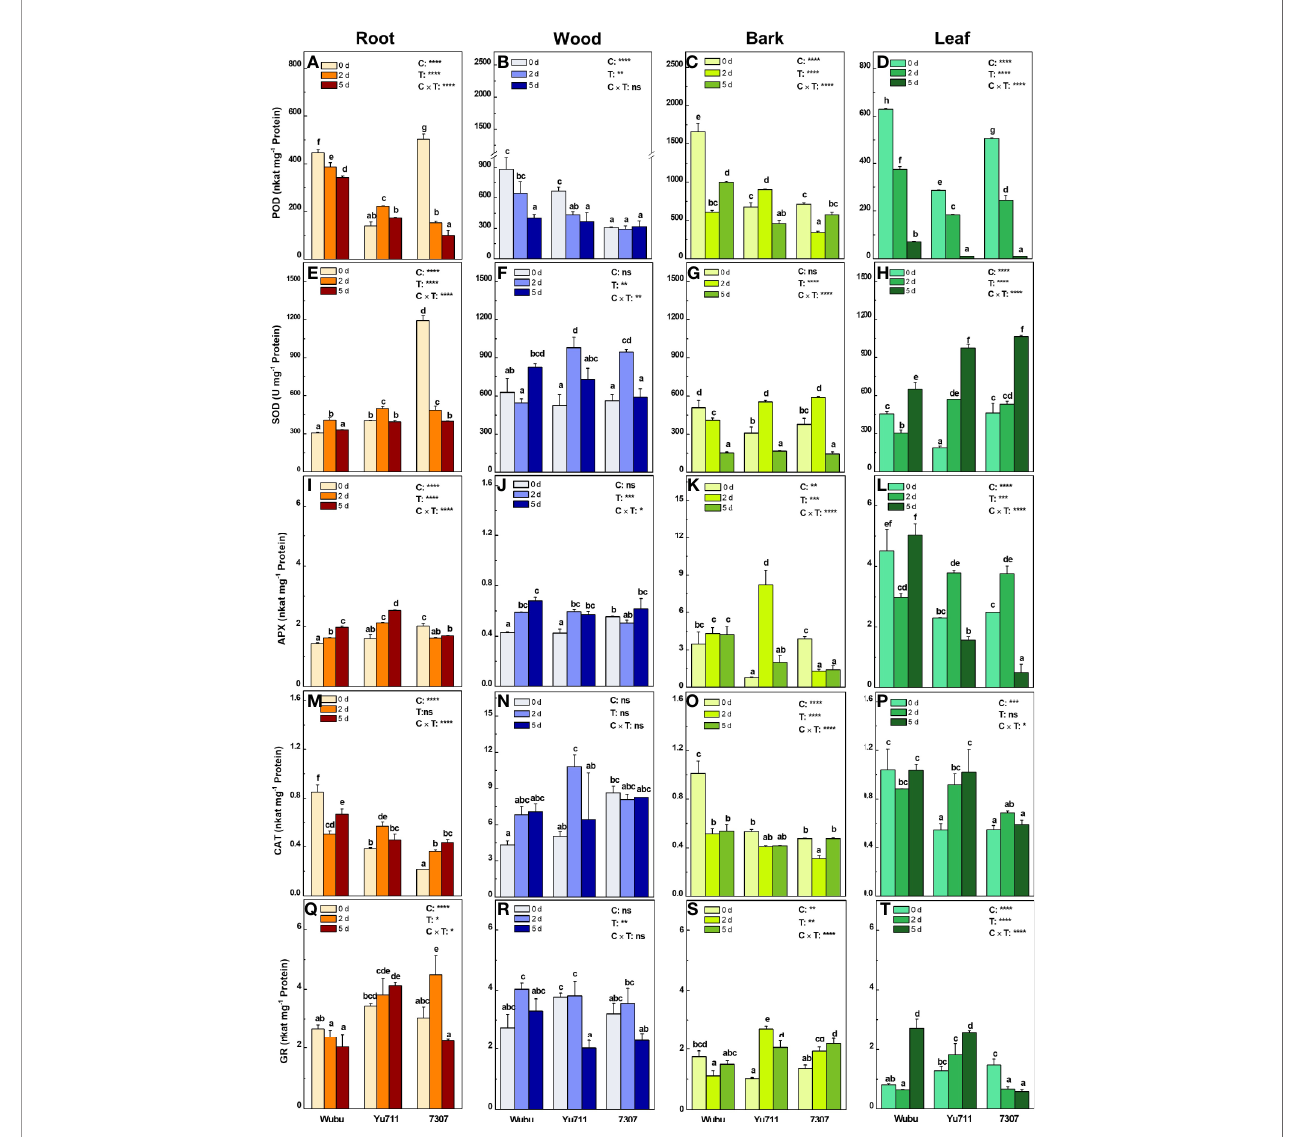
FIGURE 7 | Activities of POD (A – D) , SOD (E – H) , APX (I – L) , CAT (M – P) and GR (Q – T) in roots, wood, bark, and leaves of mulberry cultivar Wubu, Yu711, and 7307 exposed to progressive drought stress for 0, 2, and 5 days (denoted as 0 d, 2 d, and 5 d), respectively. The bar indicates mean ± SE (n = 6). Different letters on the bars indicate signi fi cant difference. ANOVAS of cultivars (C), time (T) and their interaction (C × T) are also indicated. * P < 0.05; ** P < 0.01; *** P < 0.001; **** P < 0.0001; ns, not signi fi